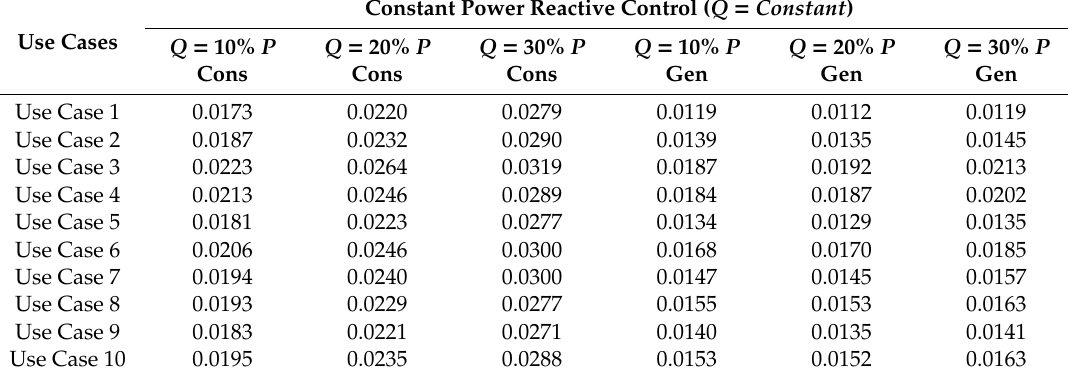
Table A3. Constant power reactive control: Losses.